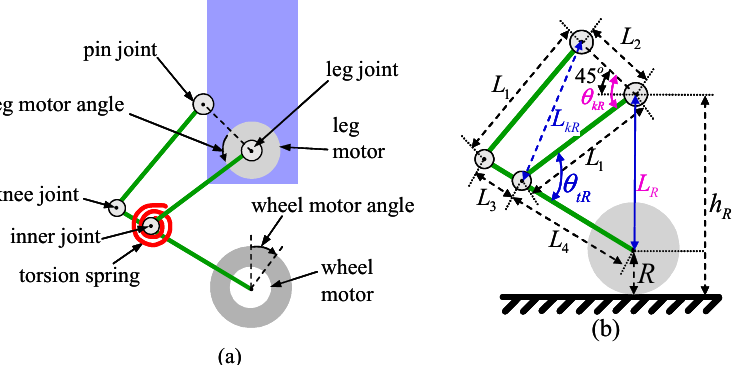
Figure 1. Mechanical structure. ( a ) Leg components. ( b ) Kinematic model of the right leg.